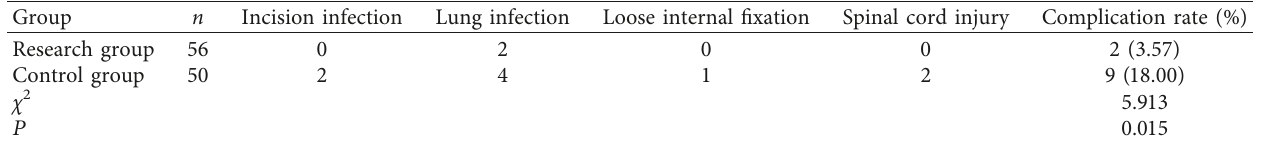
Table 6: Comparison of surgical complications between the two